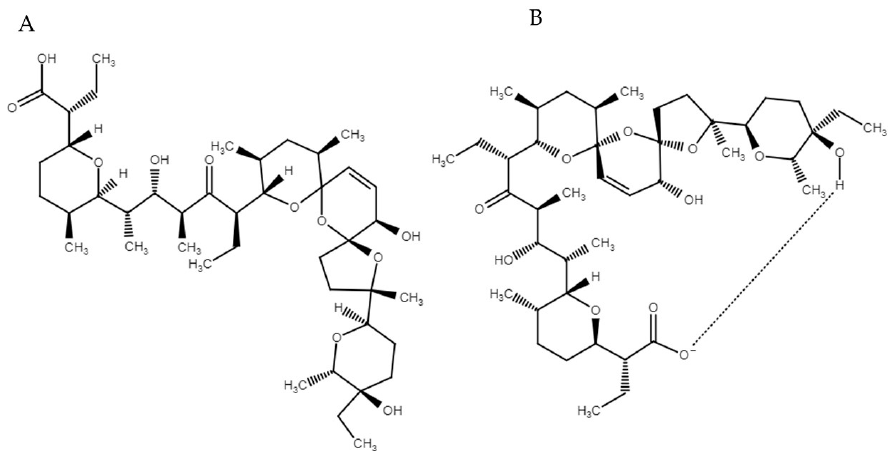
Figure 1. Chemical structure of salinomycin [5,31] in native form ( A ) and in pseudocyclic form ( B ) (Figure created with chem-space.com [accessed on 20 June 2021]).